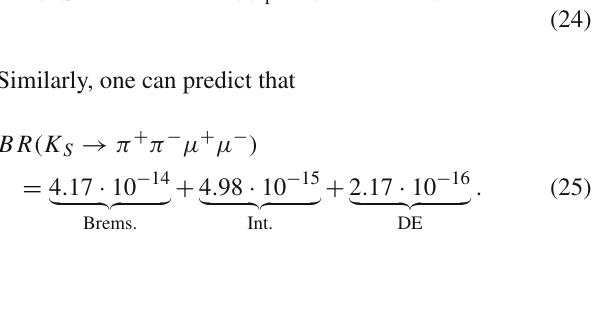
of 10 − 18 GeV − 1 . The contour plot is ’spikier’ the lower the q values are, a pattern mostly dictated by the structure of the Bremsstrahlung term = N − N 14 15 E